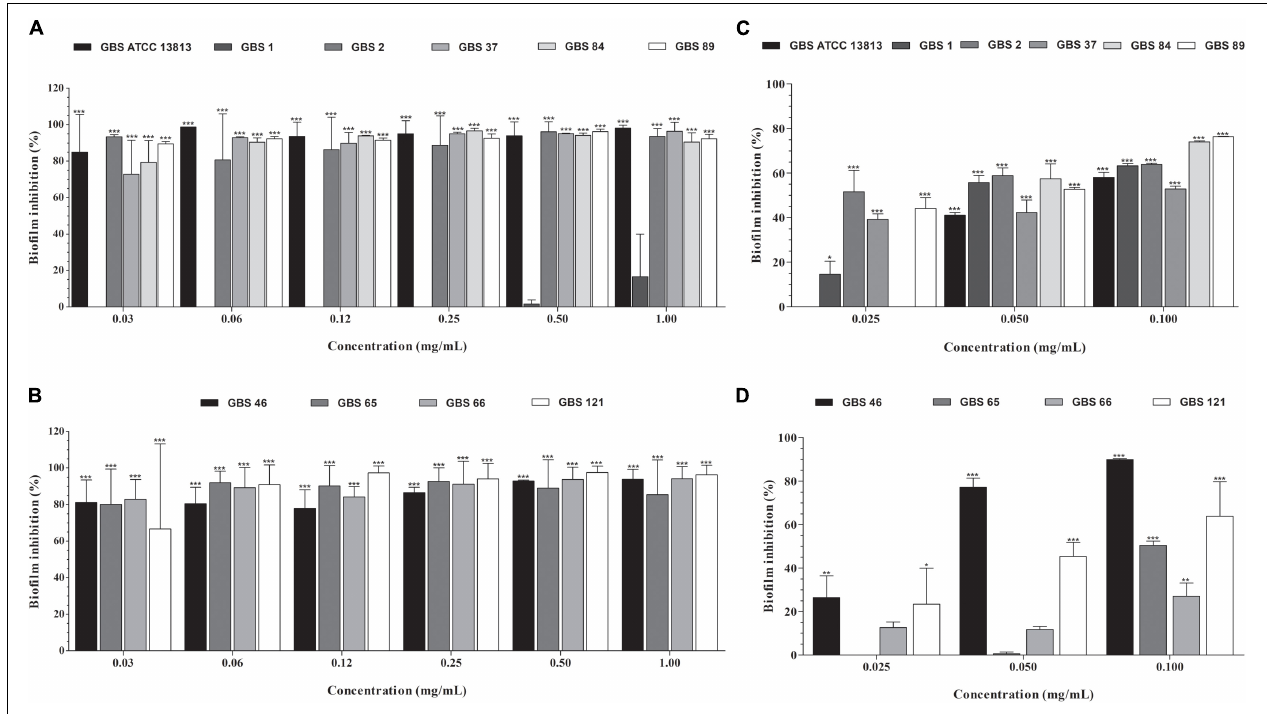
FIGURE 2 | Inhibitory activity of oleoresin from C. officinalis (A,B) and kaurenoic acid (C,D) on Streptococcus agalactiae biofilms. Established biofilms (24 h) of erythromycin- and/or clindamycin-susceptible (A,C) and -resistant (B,D) GBS strains were treated with different concentrations of copaiba oil or kaurenoic acid, and the metabolic activity of sessile cells was assessed by XTT-reduction assay. Values are mean ± standard deviation of two experiments. The asterisks indicate a significant reduction of metabolically active sessile cells treated with copaiba oil compared to untreated cells ( ∗ P < 0.05, ∗∗ P < 0.01, and ∗∗∗ P < 0.001).